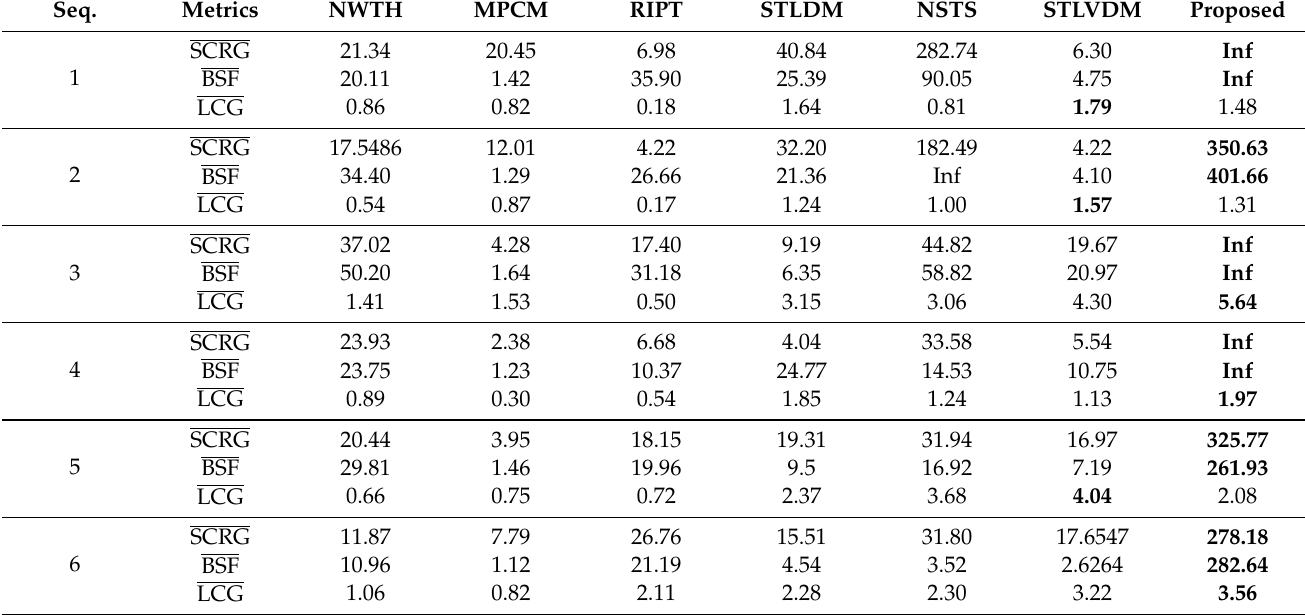
Table 3. Quantitative comparison of different methods on